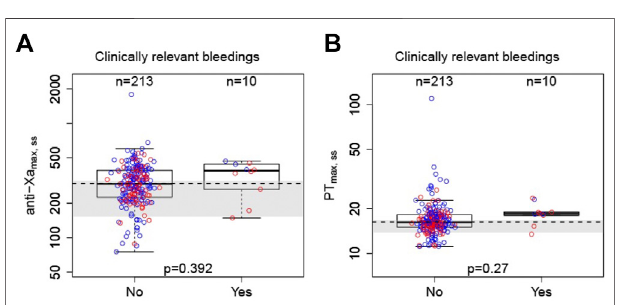
FIGURE 3 | Correlation between peak PT or anti-Xa parameters with bleeding events. A : anti-Xa; B : PT. Boxes indicate 25th – 75th percentiles, whiskers represent extension of the box with 1.5 times the interquartile range, and black horizontal lines represent the median. The blue circles are individual predicted values for standard dose or overdose, and the red circles are individual predicted values for low dose. The shaded area represents the expectedanti-Xa/PTrangesconvertedfromestimatedparametersatasteady state (Steffel et al., 2021).